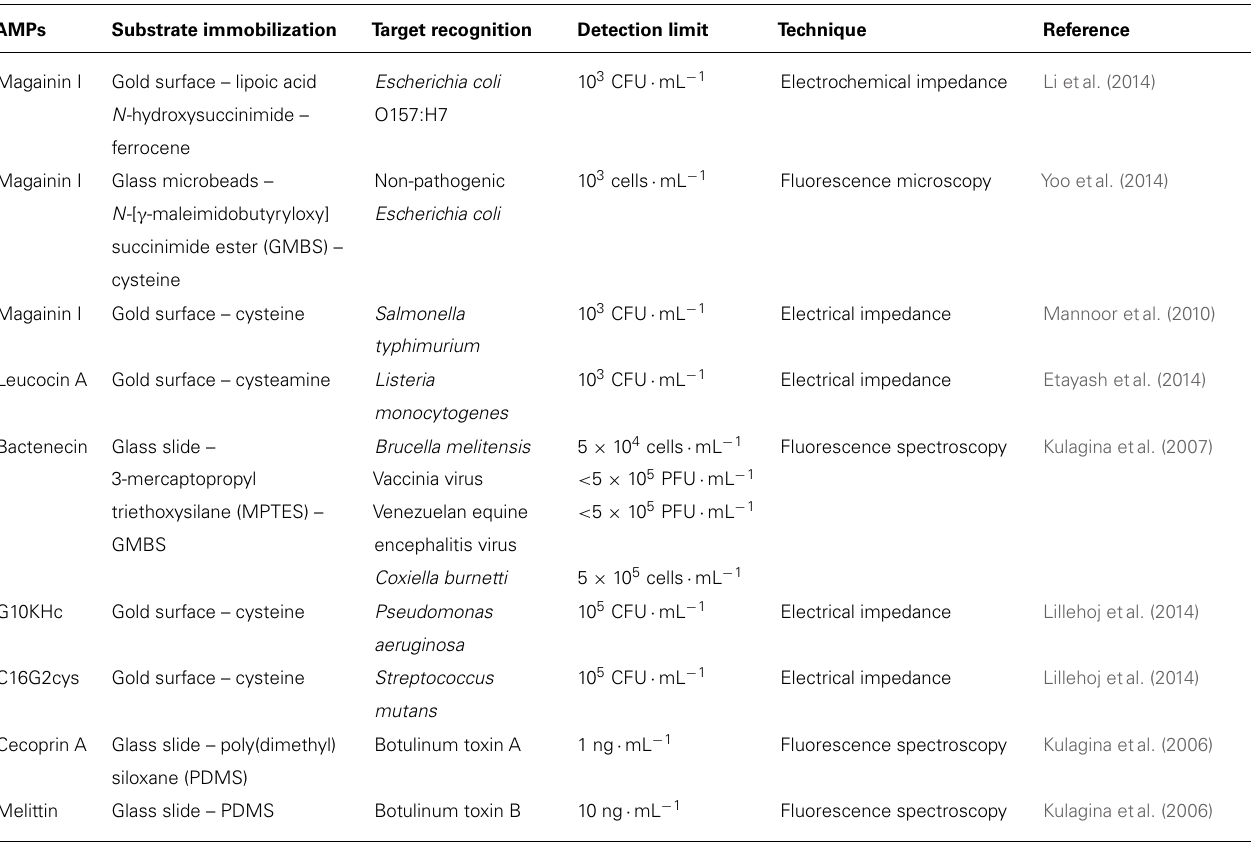
Table 1 |Antimicrobial peptides, their immobilization substrates and molecular targets with the respective detection limits obtained through different techniques.